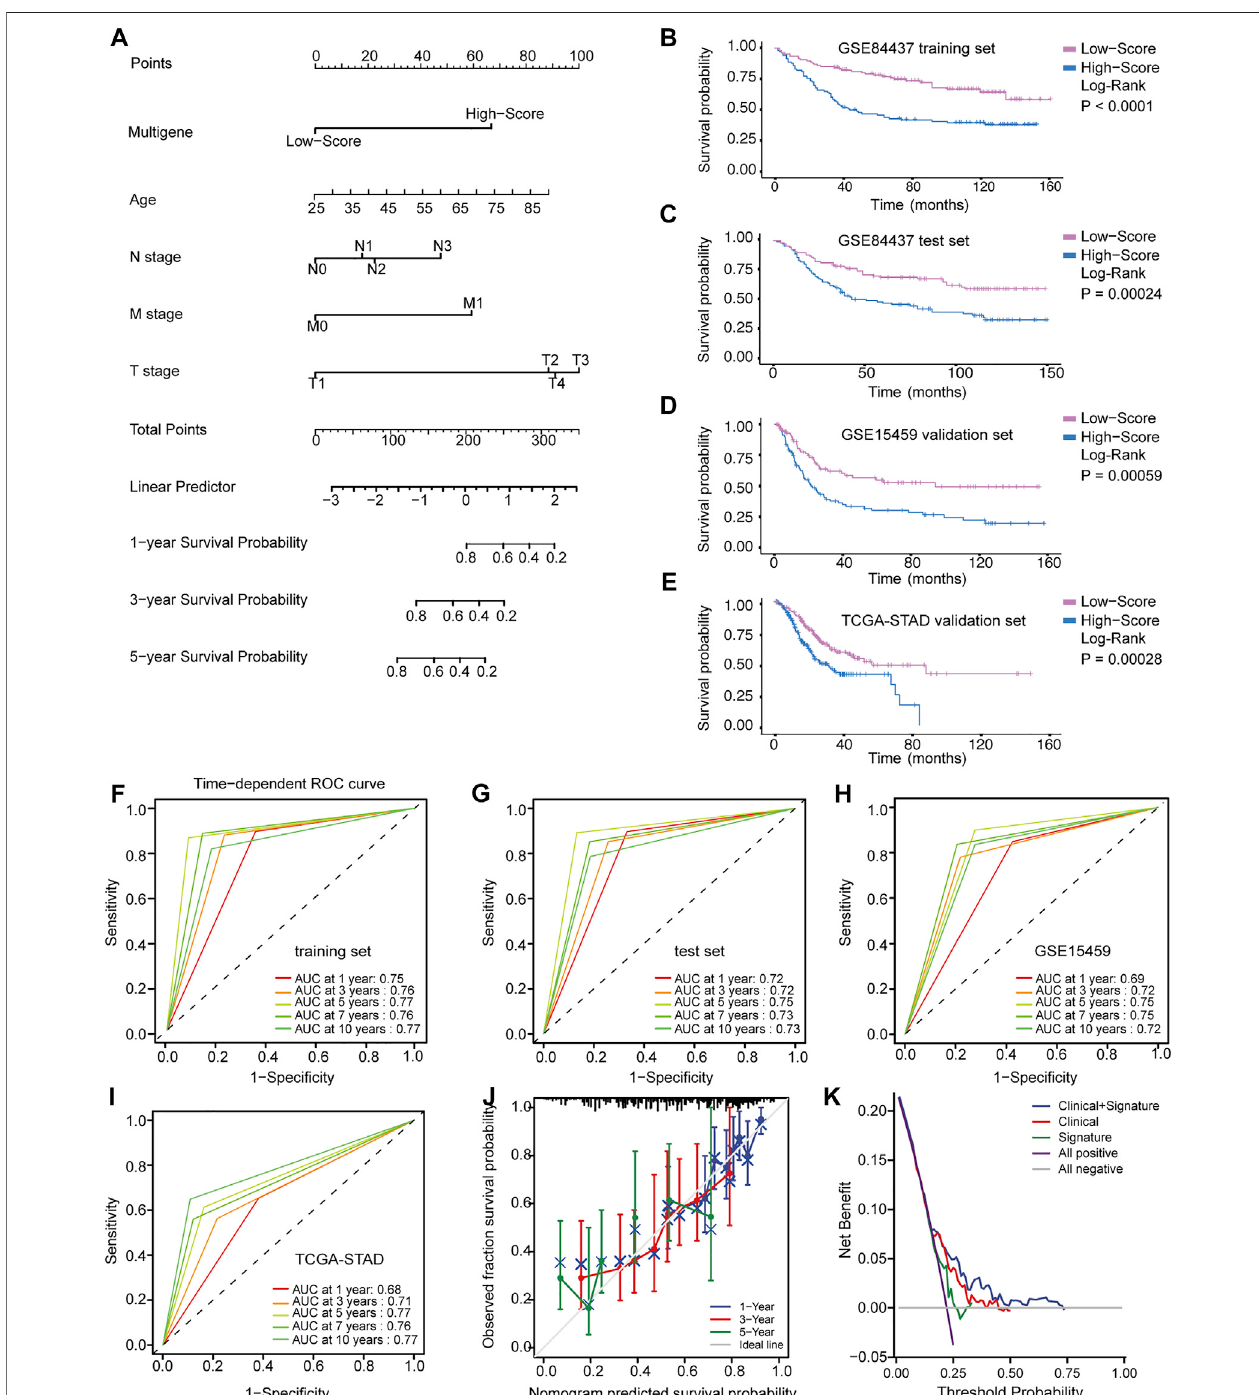
FIGURE 4 | Identi fi cation and application of the multigene signature. (A) Nomogram predicting the probability of survival for GC patients at 1, 3 and 5 years (B – E) Kaplan-Meiercurvesofthetrainingandvalidationdatasetsonoverallsurvival. (F – I) Time-dependentROCcurvesofnomograminthetrainingandvalidationdatasets. (J) Calibration curve of predicted results compared to actual observation results. (K) DCA demonstrating the net bene fi t of nomogram, clinical features model, and multigene signature.